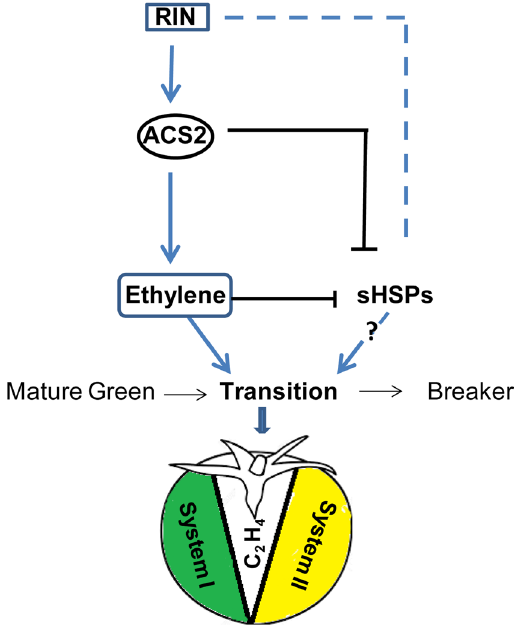
Figure 7. A schematic illustration showing additions to the previous fruit ripening model 60 modified to include the SlHSP ( 17 . 6 , 20 . 0 , 20 . 1 ) genes with their proposed role in the transition from mature green to ripening phase of tomato fruit. RIN regulates ethylene biosynthesis in ripening tomato fruit involving ACS2 transcription (pointed blue arrows). During System1 ripening, low levels of auto-inhibitory ethylene are synthesized via SlACS1A , 6 and SlACO1 , 3 , 4 60 . At the transition stage, the ripening regulator RIN plays a critical role, where SlACS4 is induced to initiate a large increase in auto-catalytic ethylene that negatively feeds back on System I. SlACS2 , 4 and SlACO1 , 4 are involved in high ethylene production through System II 60 . SlHSP genes (sHPSs) are transiently suppressed by ethylene at the ripening-transition mediated by the RIN protein (blunt headed black arrows). Ethylene and ACS2 exert negative regulation of the three class-1 SlHSP gene transcripts via interactions involving RIN protein (blue